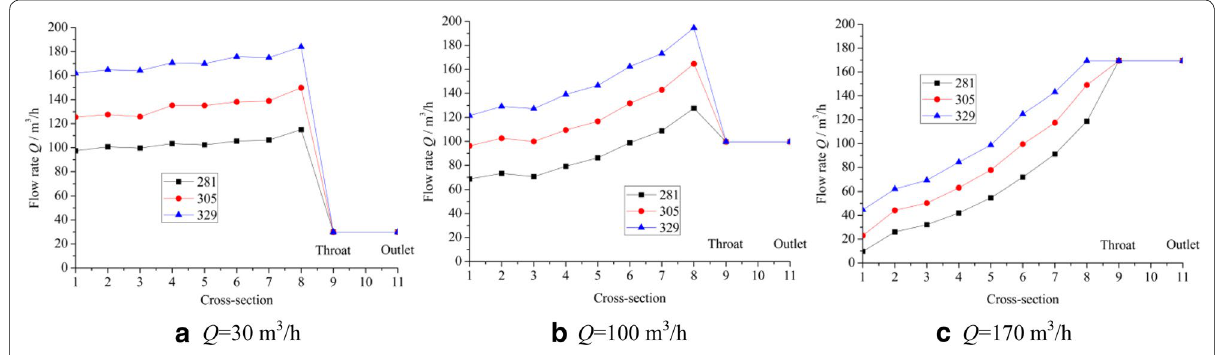
Figure 6 Hydraulic loss in volute